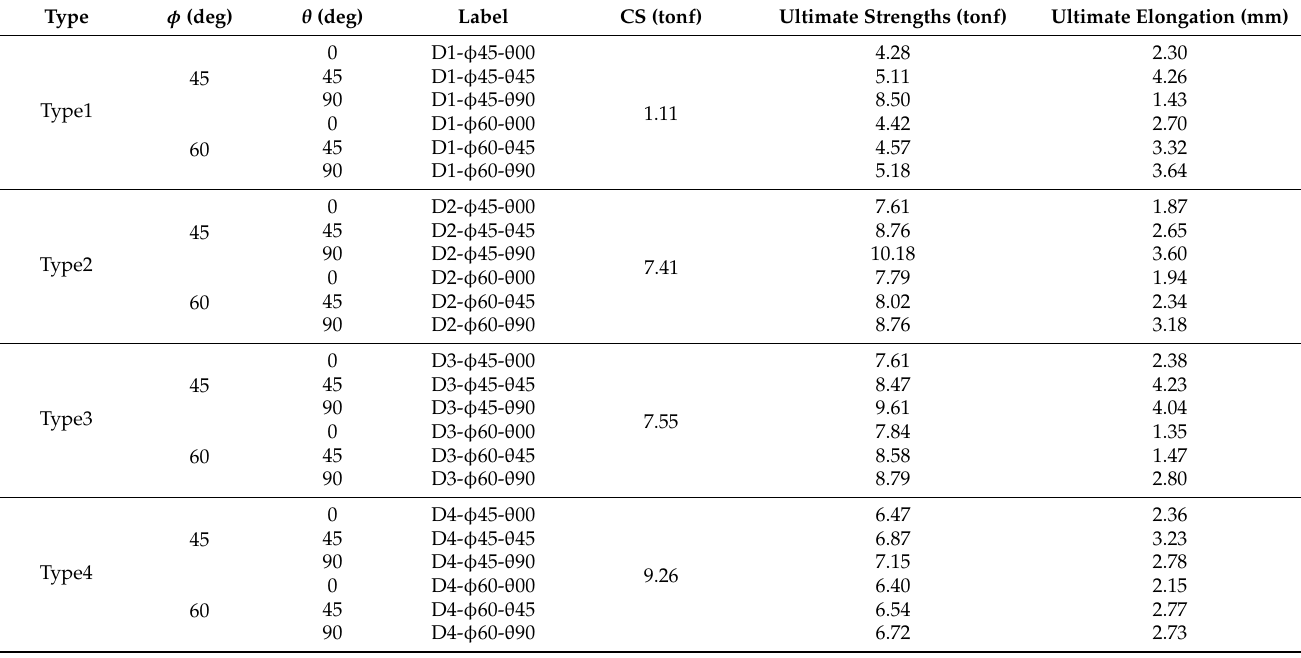
Table 7. Nonlinear FEA results for